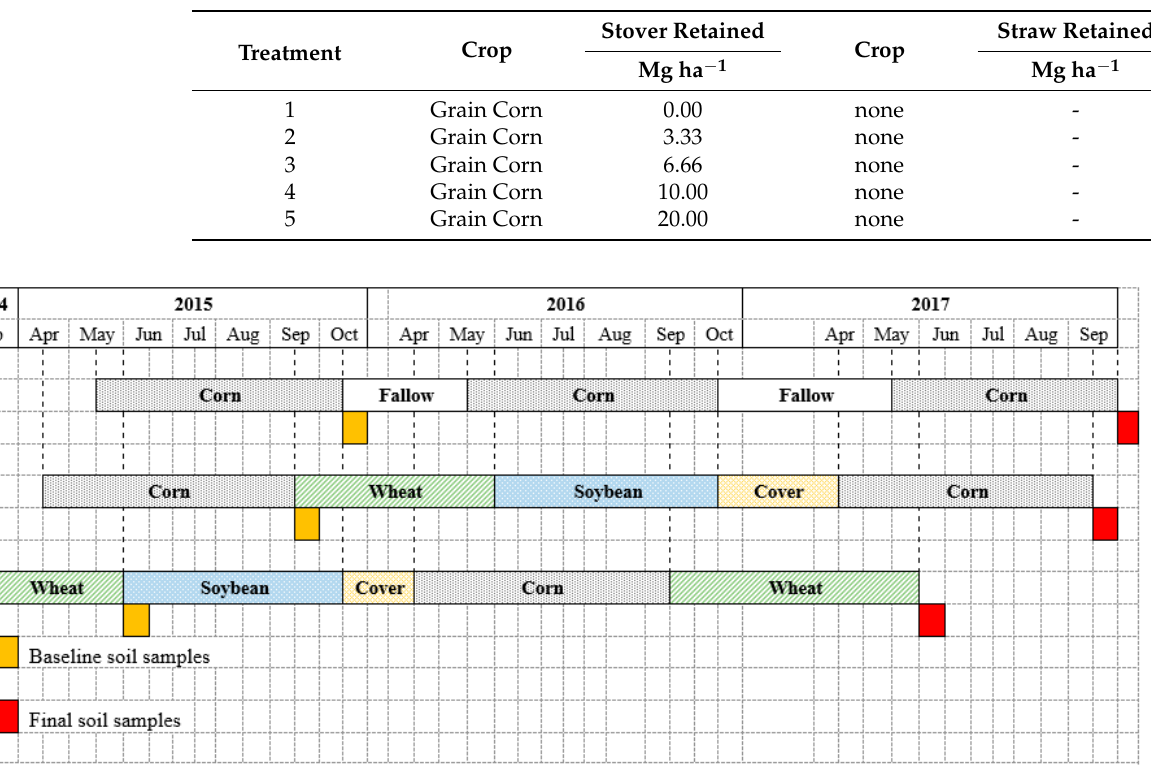
Figure 1. Chronological chart with details of the full crop rotations and soil sampling framework in Blacksburg (BB) and New Kent (NK1 and NK2), VA, USA. Blacksburg (BB) and New Kent (NK1 and NK2), VA,